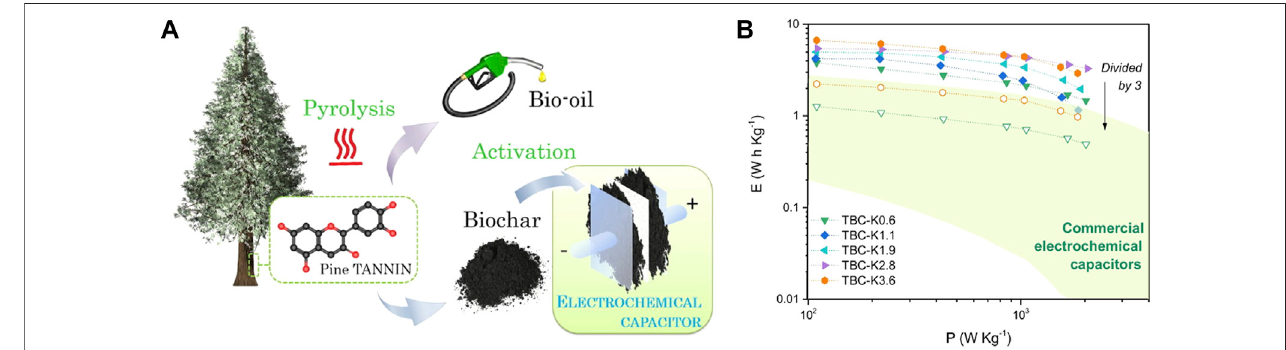
FIGURE 7 | (A) Schematic representations of the upgrading of biochars obtained as a byproduct of bio-oil production from pine bark tannin as precursors for the fabrication of SC electrodes. (B) Ragone plots of symmetrical SCs based on tannin biochars (TBCs) activated with different ratios (from 0 to 0.6 g KOH per gram of biochar) (full symbols) and Ragone-like curves of the packaged device extrapolated by dividing the speci fi c energy values by a factor of 3 (empty symbols). Commercial electrochemical capacitor technologies have been included in the green zone. Reprinted with permission from (Pérez-Rodríguez et al., 2021).